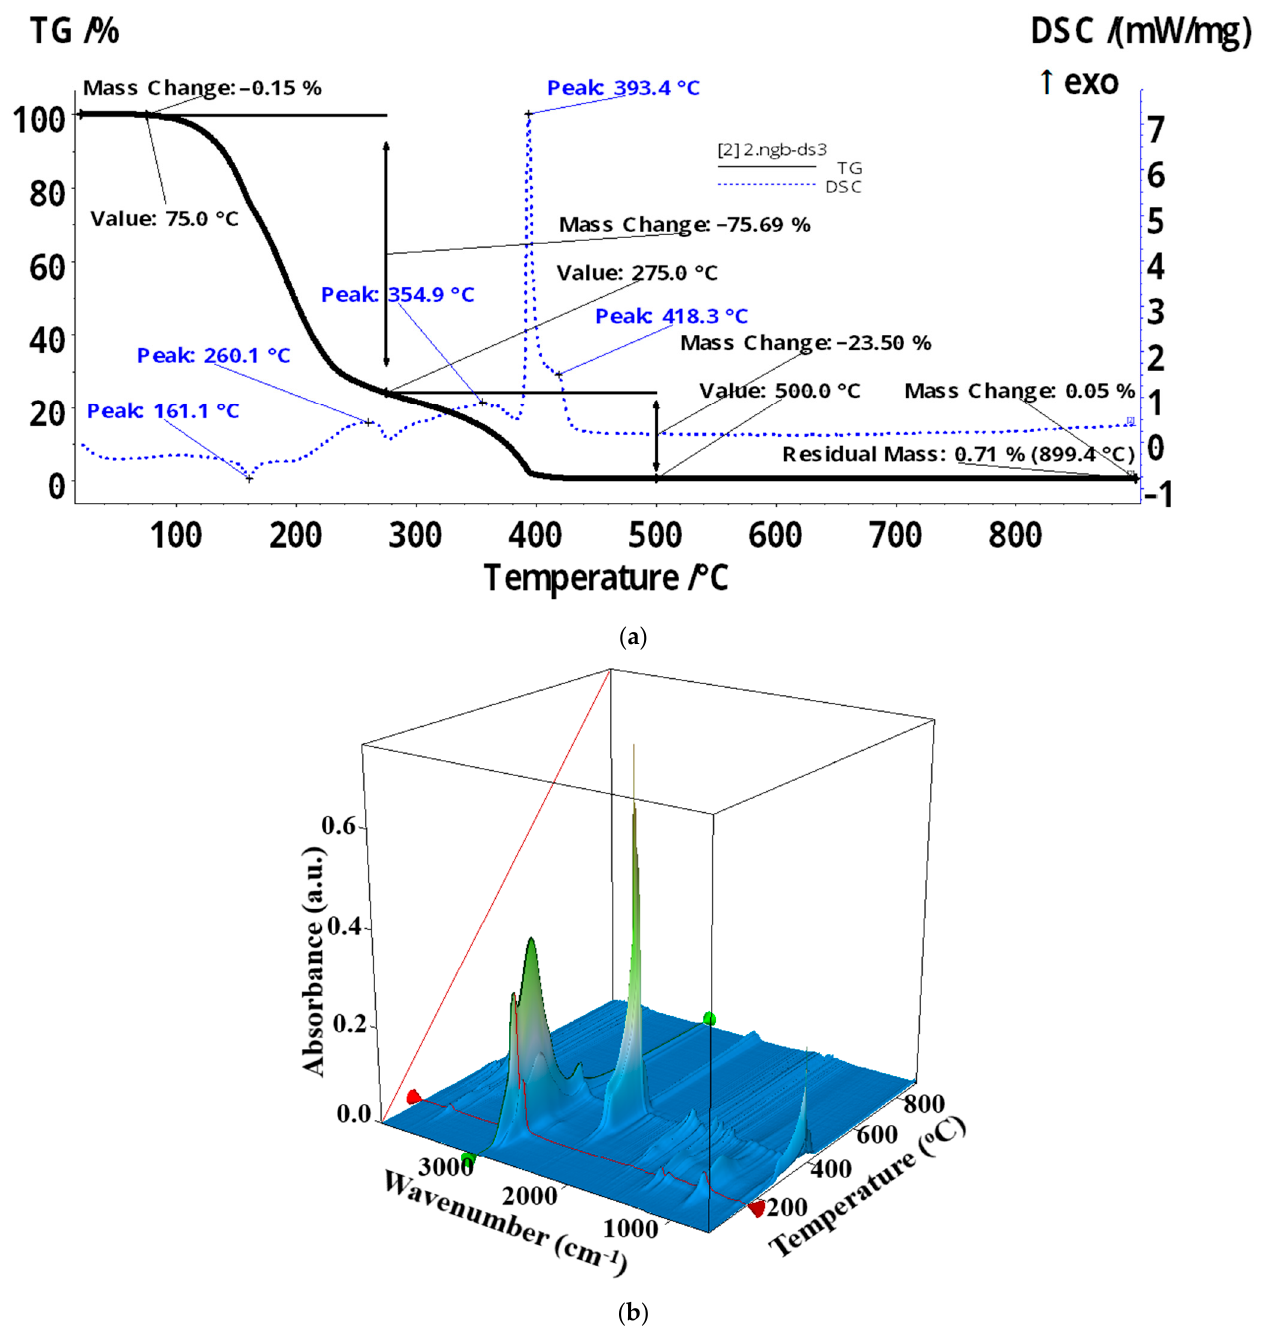
Figure 7. Thermal characteristics ( a ) and the 3D plot of FTIR spectrum vs. temperature ( b ) for the evolved gases from the Os–PPM i sample.